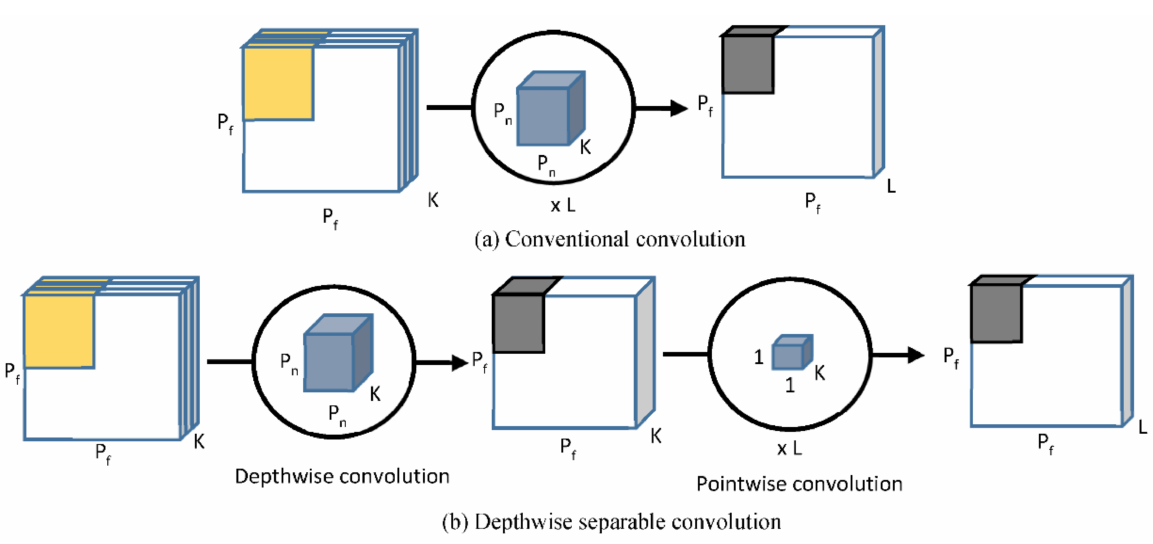
Figure 5. Schematic representation of ( a ) conventional vs. ( b ) depthwise separable